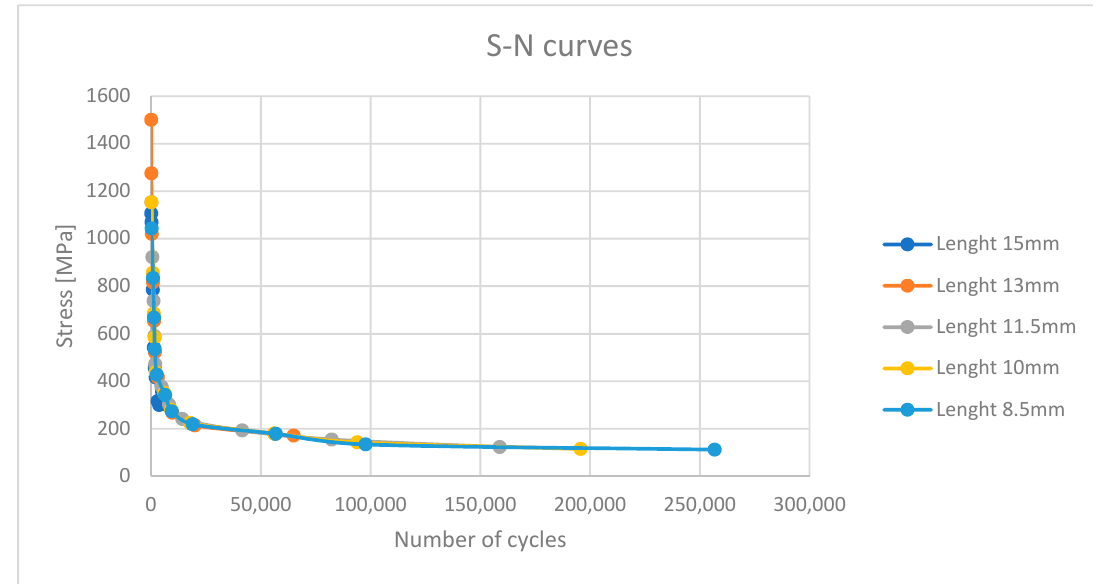
Figure 5. S–N curves obtained from the results of Table 2.